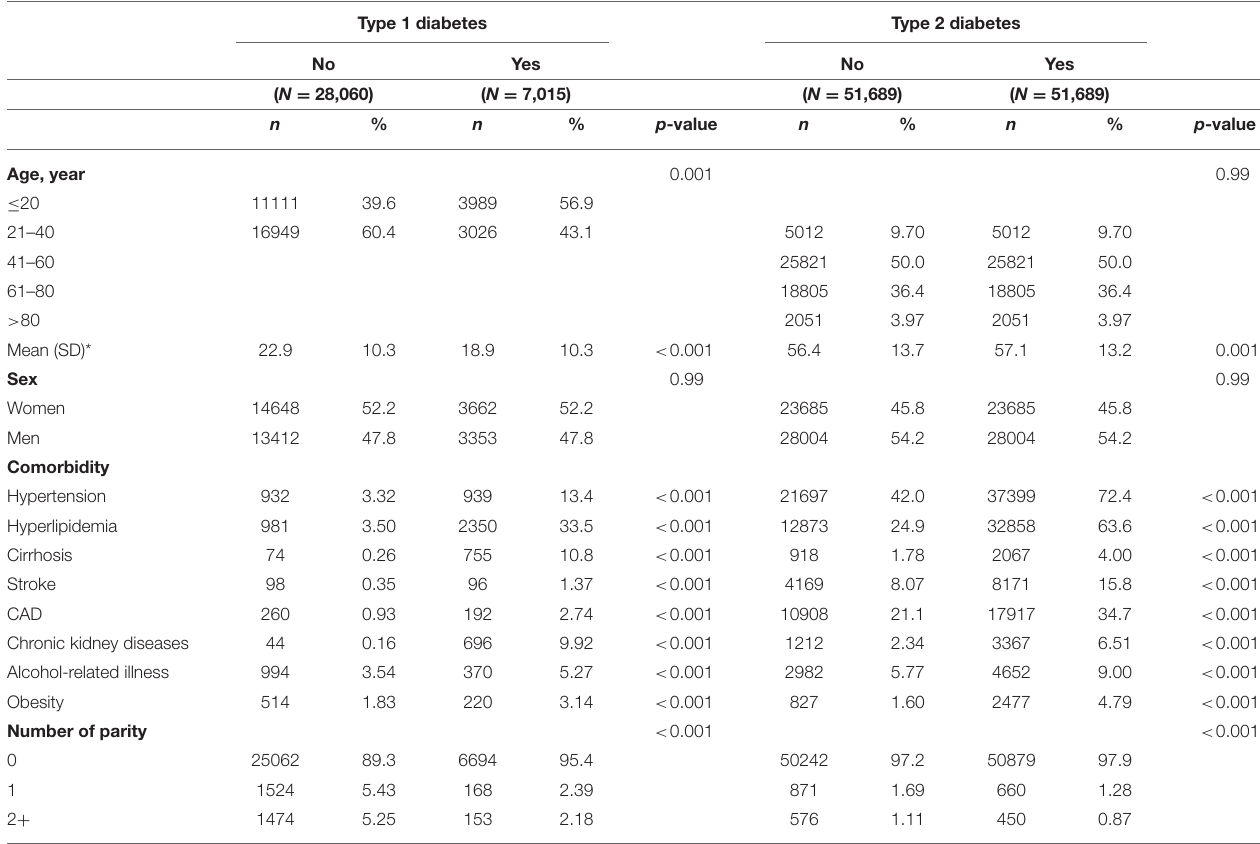
TABLE 1 | Characteristics of patients with and without diabetes.